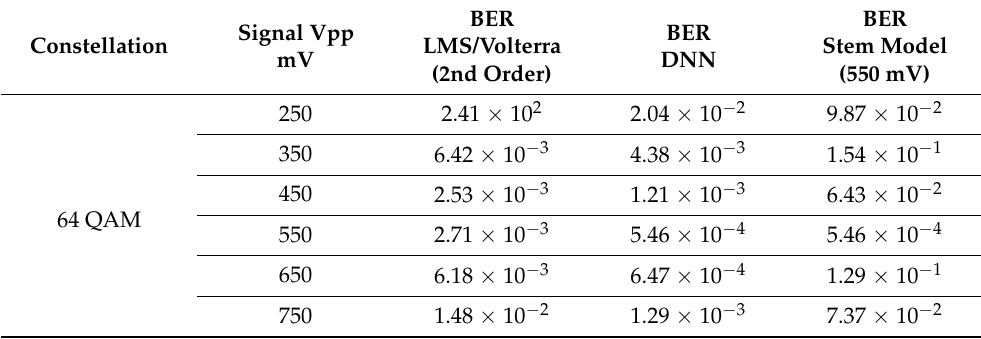
Table 2. BER performance between LMS/Volterra combination and DNN trained using exhaustive strategy. Models are trained from random initialization. The best BER indicates the training set that is an ideal source domain.